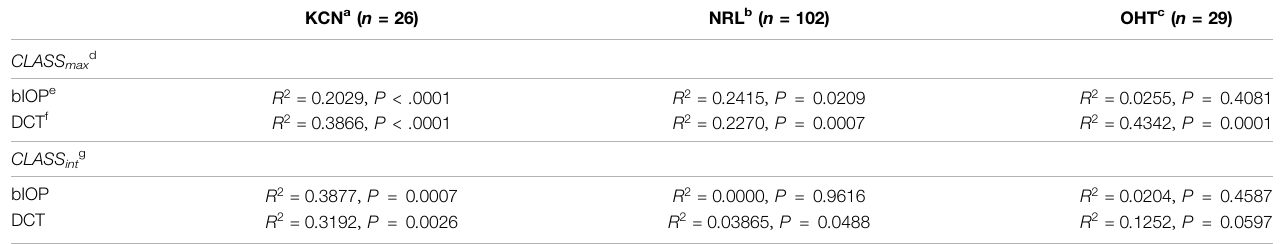
TABLE 3 | Regression results for CLASS max and CLASS int vs. IOP.